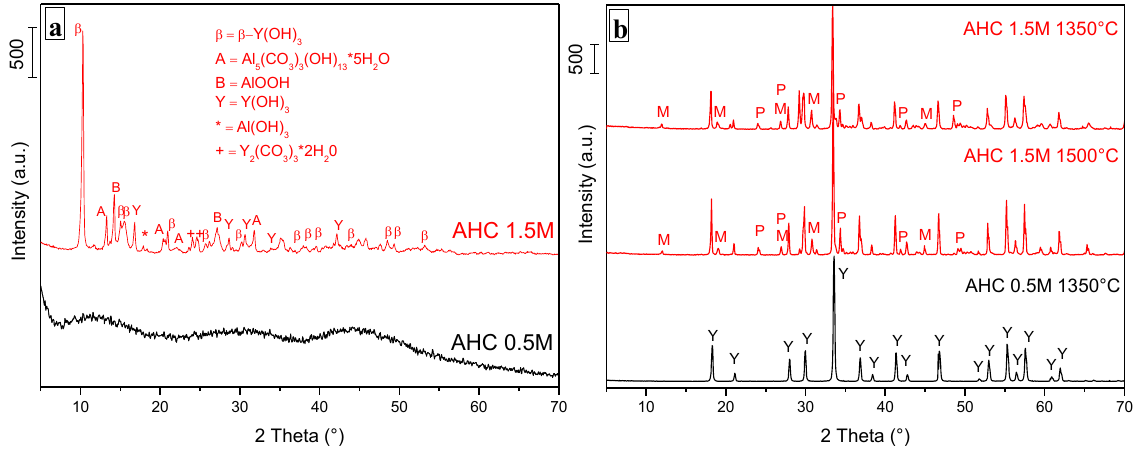
Figure 1. XRD patterns of YAG cl -AHC1.5 and YAG cl -AHC0.5 as ( a ) dried and ( b )